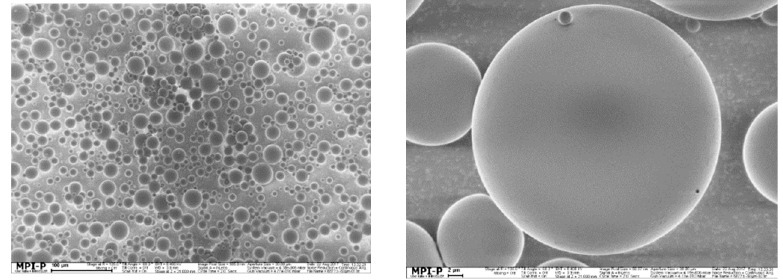
Figure 1. SEM images of the glass microspheres.